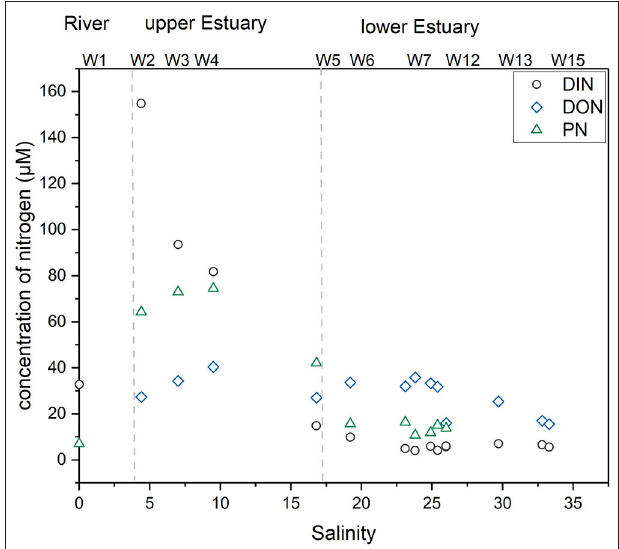
FIGURE 8 | Nitrogen variation vs. salinity in the surface layer of the